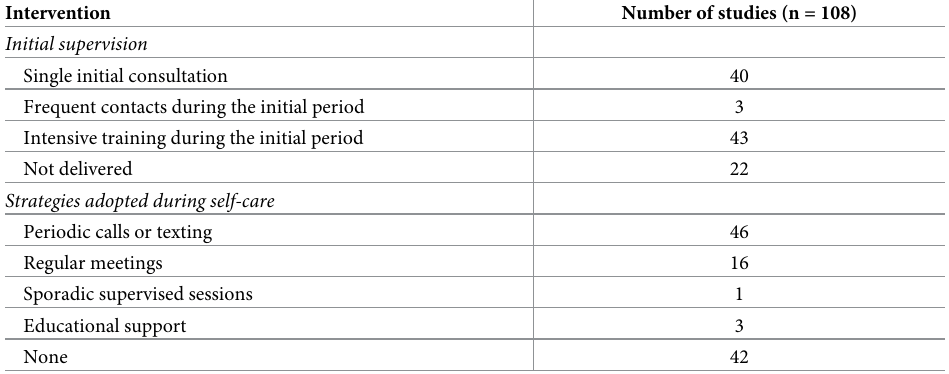
Table 4. Supervision provided and strategies adopted to promote self-care behaviors in breast cancer survivors’